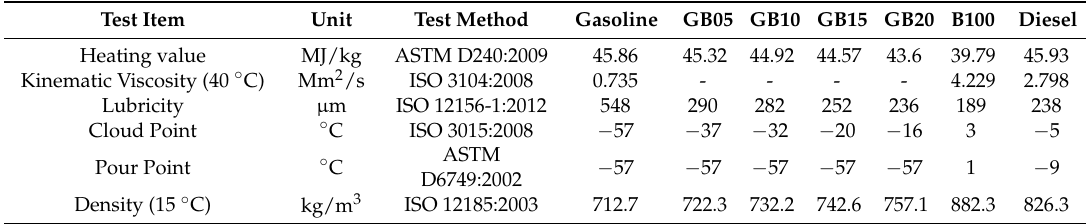
Table 2. Physical properties of the fuels.